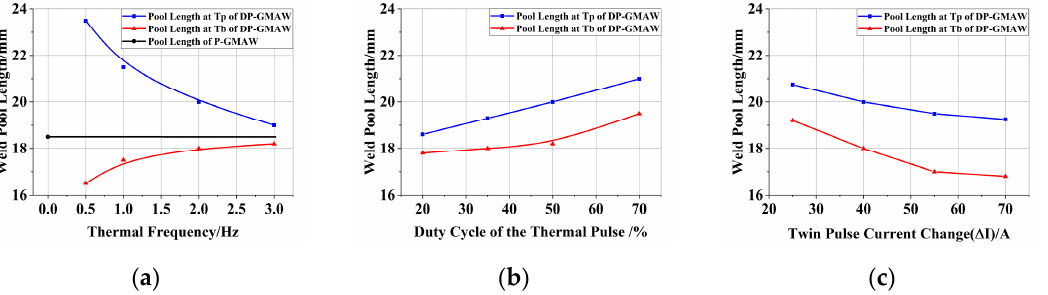
Figure 13. Variation of weld pool length with ( a ) heat thermal frequency; ( b ) duty cycle of the thermal pulse; ( c ) current amplitude of thermal pulse.